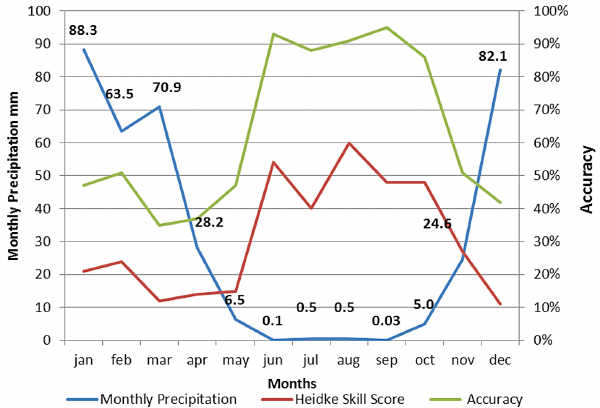
Figure 5. Monthly average precipitation and the corresponding pre- diction accuracy by ANN model on Maharloo